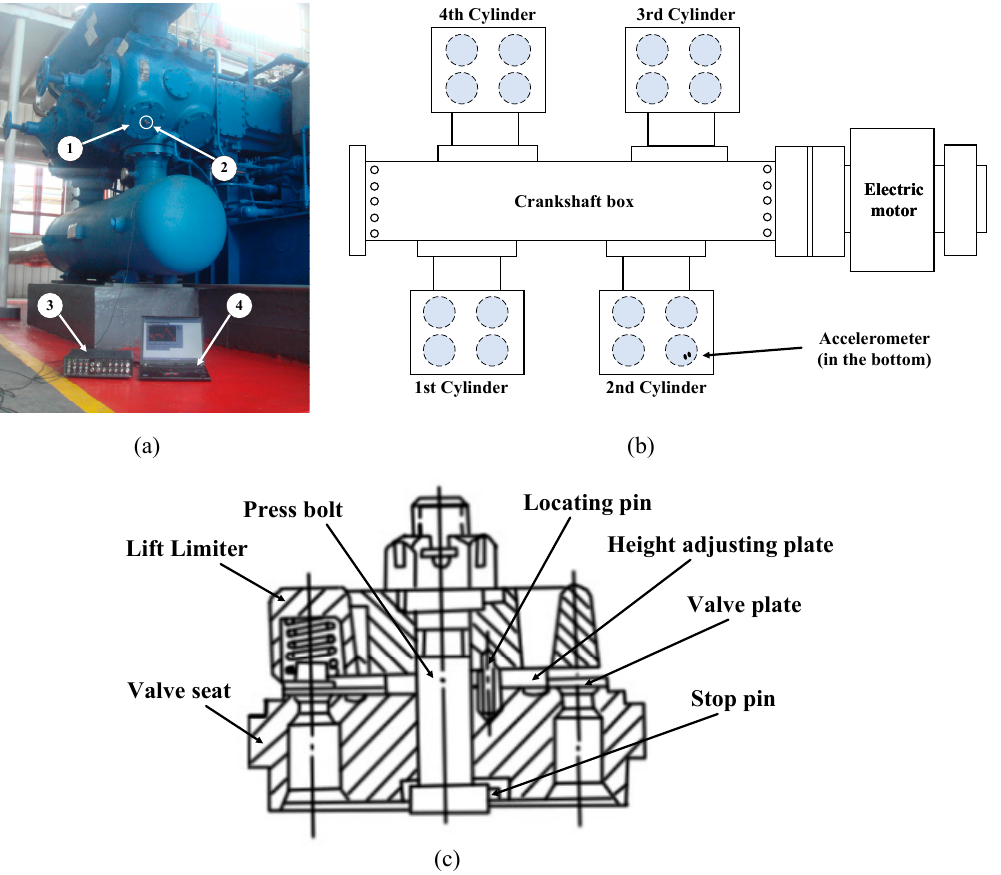
Figure 4. Experimental setup: ( a ) Reciprocating compressor and data acquisition system: 1. exhaust valve, 2. accelerometer on the exhaust valve lid, 3. data acquisition board, 4. control panel. ( b ) Structural sketch of the reciprocating compressor. ( c ) Structural sketch of the exhaust valve.